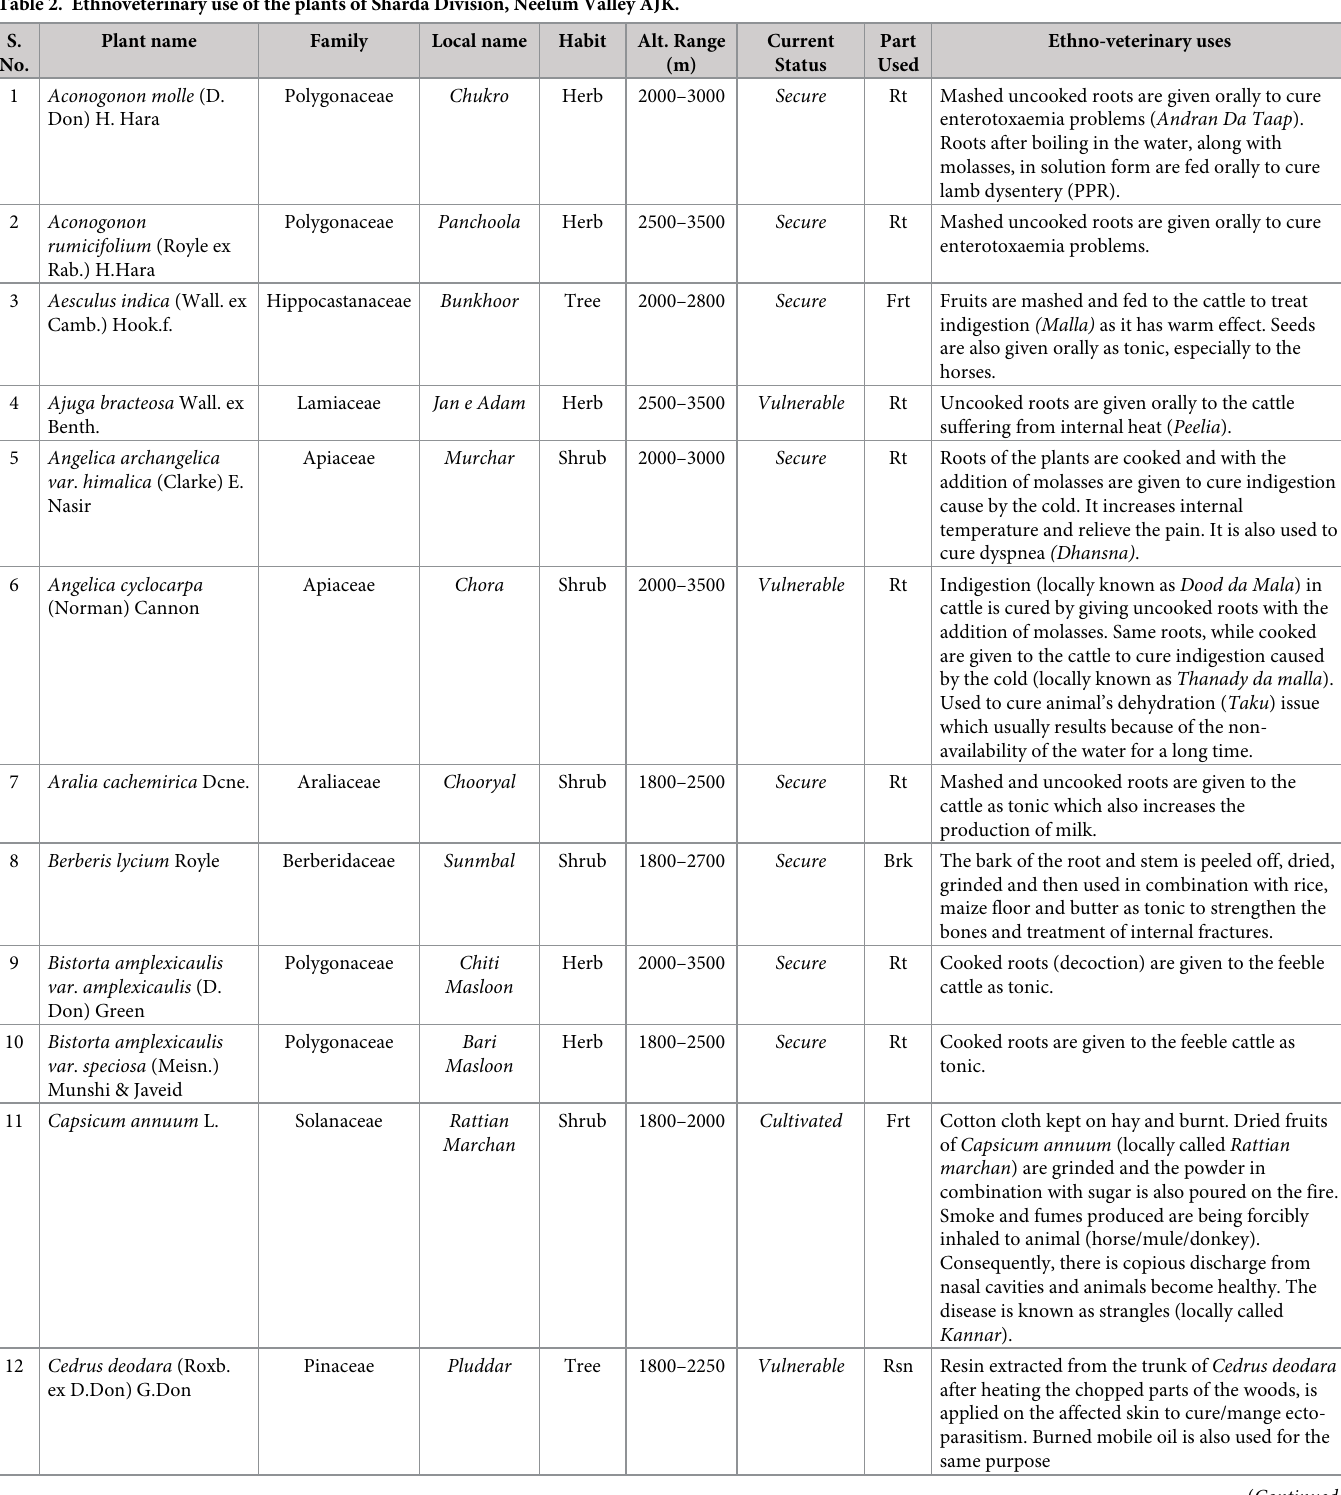
Table 2. Ethnoveterinary use of the plants of Sharda Division, Neelum Valley AJK. S.